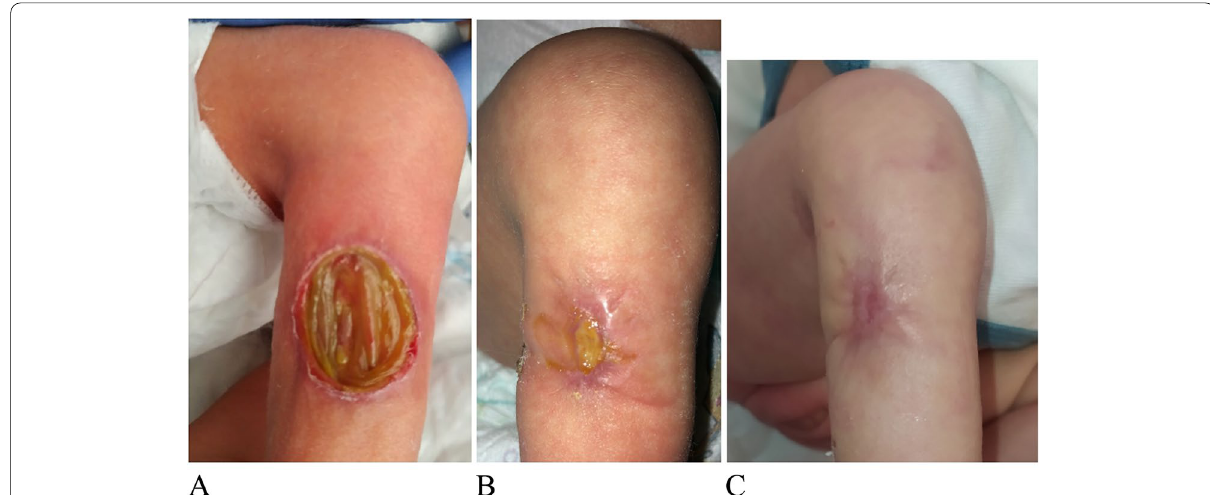
Fig. 3 Patient 3. A Skin defect on the lateral aspect of the lower limb at birth. B Skin defect appearance after a month of follow-up. C Immature scar after 2